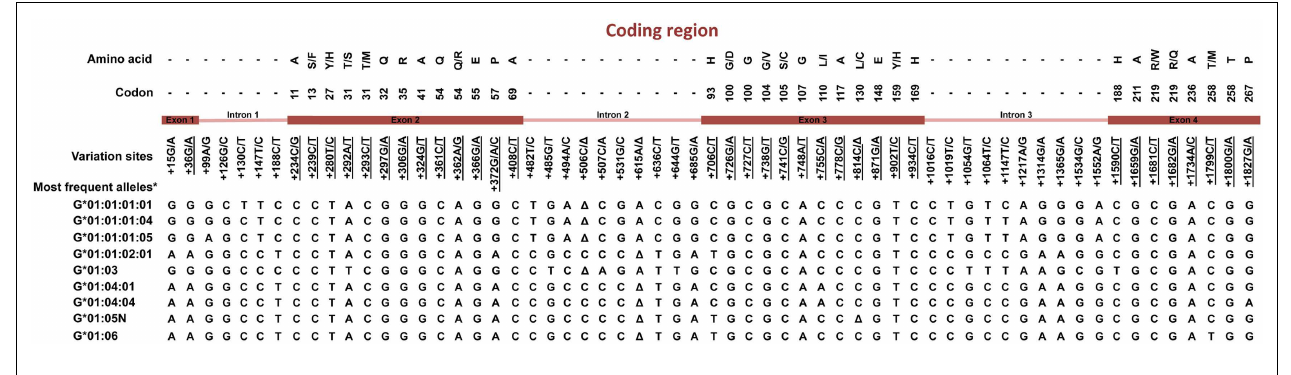
FIGURE 3 |Variation sites at the coding region of the HLA-G gene from exon 1–4 . Polymorphic sites associated with diseases presented in this review are underlined. *Haplotypes presenting a global frequency higher than 1% in worldwide populations. Amino acids: A, alanine; S,